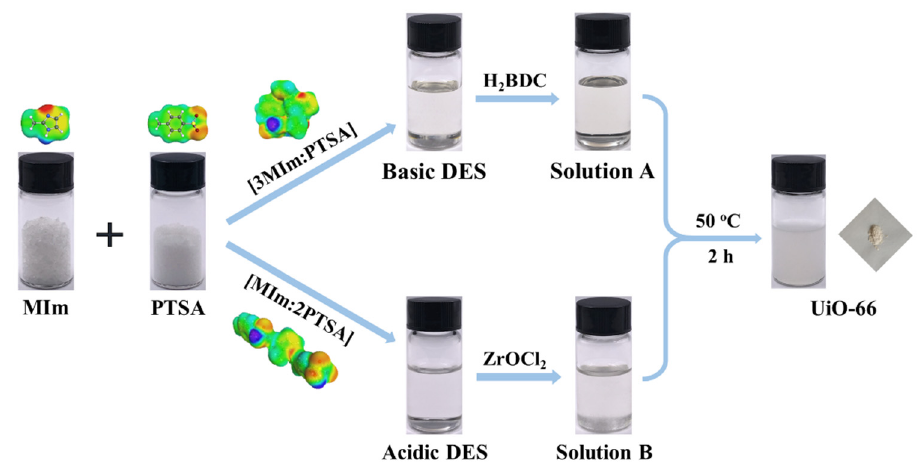
Scheme 1. Schematic illustration of the preparation process of